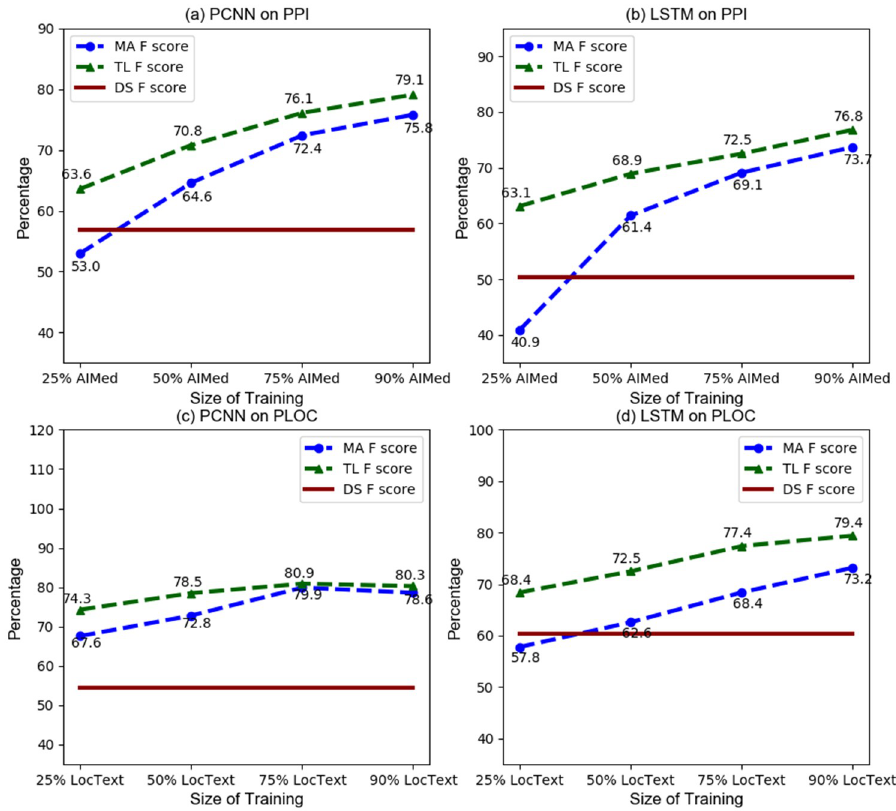
Fig 5. Trend of F score with different size MA data in transfer learning. MA F score means the F score acquired from models built on MA data only; TL F score means the F score acquired from models built on transfer learning; DS F score means the F score acquired from models built on DS